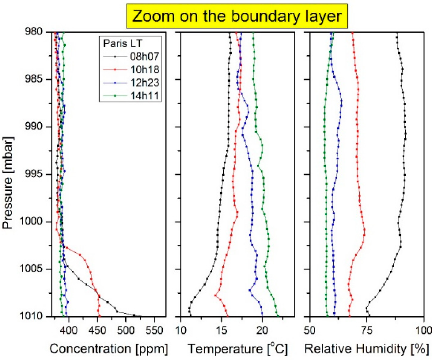
Figure 11. Zoom on the first 30 mbar of Figure 10 in order to study the boundary layer evolution during the same day. Results are in good agreement with the literature.